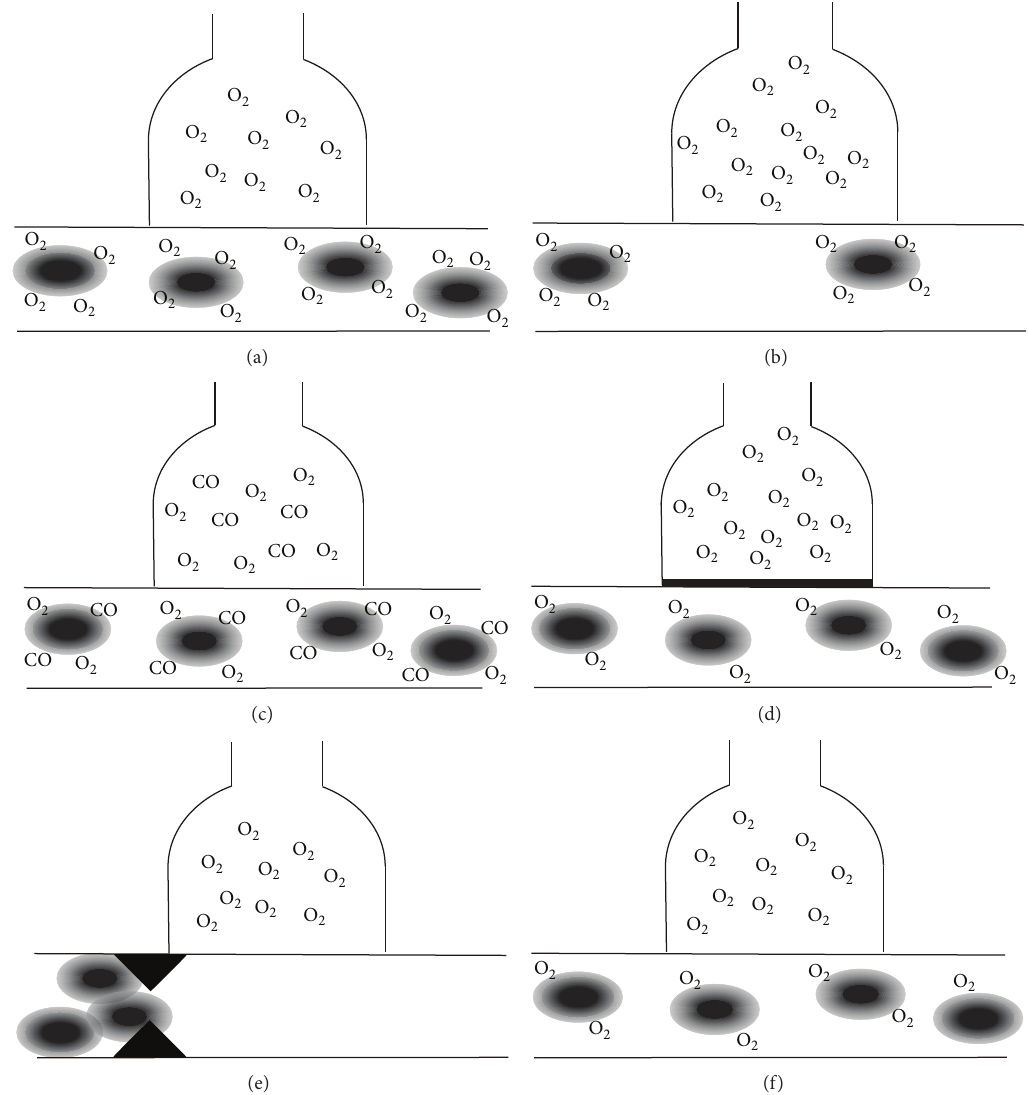
Figure 1: Explanations for reduction in DLCO: (a) normal physiology, (b) anemia, (c) high carboxyhemoglobin levels, (d) pulmonary disease (thickening of the alveolar membrane), (e) pulmonary vascular disease, and (f) Hb Aalborg. carboxyhemoglobin levels (Figure 1(c)), interstitial lung